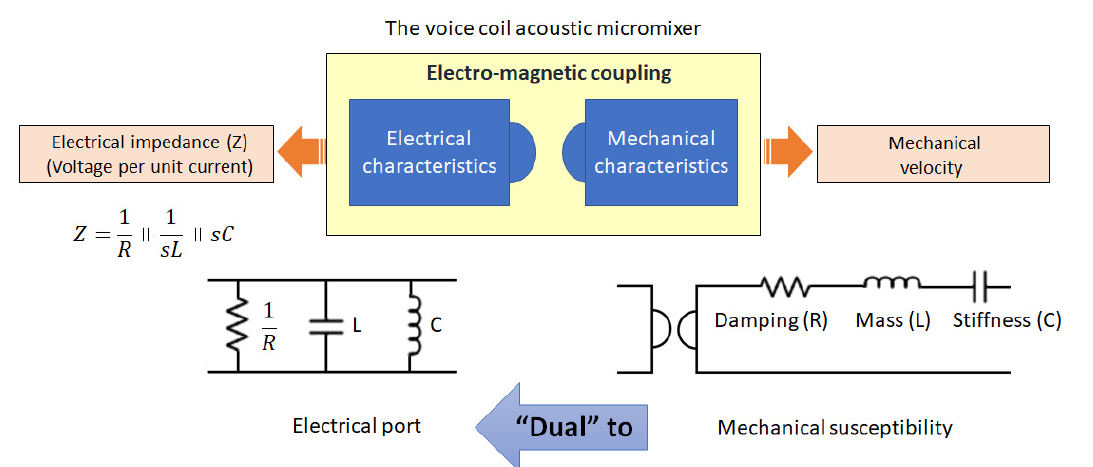
Figure 1. Mobility networking through electromagnetic coupling in the voice-coil acoustic micromixer. Without employing the gyrator for EM circuits, the mechanical components become dual when seen on the electrical side of the